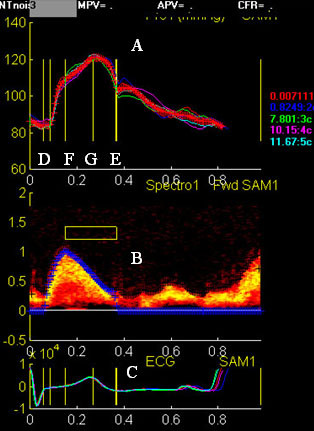
SAM analysis window. Analysis window for estimating total arterial compliance showing (A) averaged and calibrated carotid pressure waveform, (B) averaged reconstructed pulse-wave Doppler of the left ventricular outflow and (C) ECG. Cursors mark beginning (D) and end aortic ejection (E), peak aortic ejection (F) and peak pulse pressure (G).